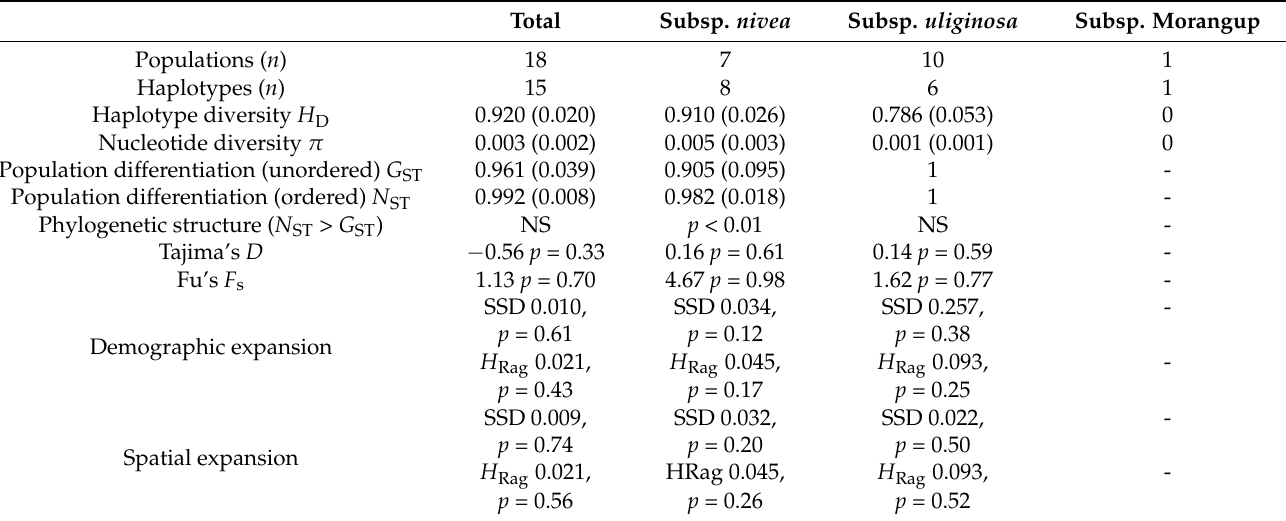
Table 2. Diversity statistics, tests of neutrality, and mismatch analyses based on sequences psb A- trn H, ndhF, trnV, and trn Q- rps 16 of chloroplast intergenic spacers regions in Banksia nivea . Total Subsp. nivea Subsp. uliginosa Subsp. Morangup